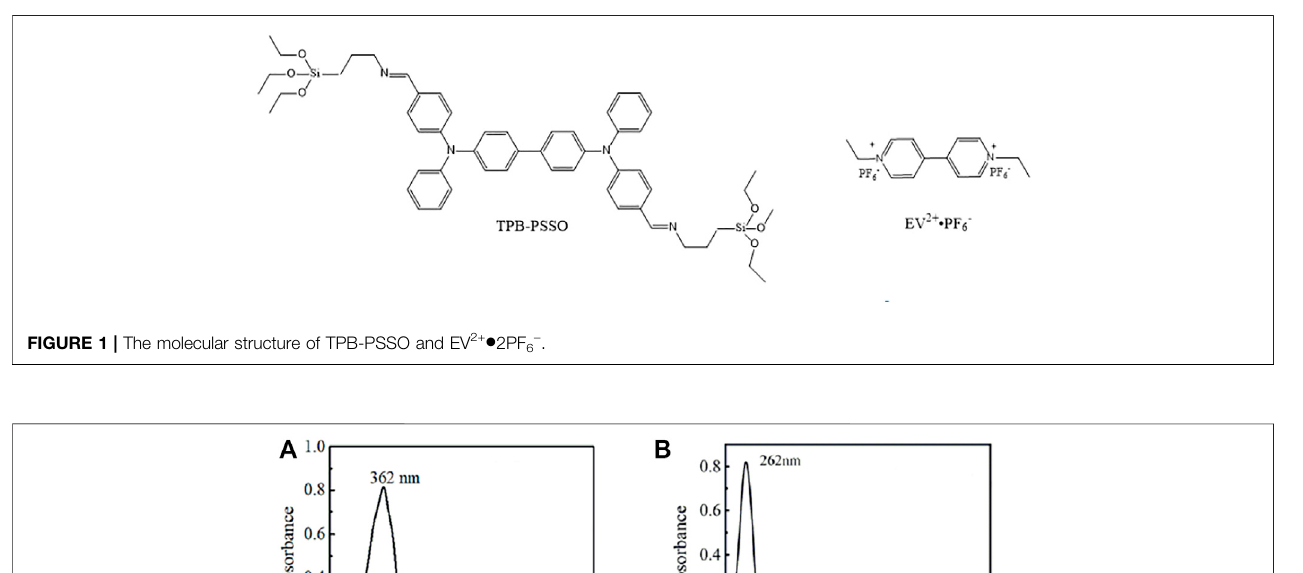
FIGURE 2 | The UV-vis spectra of TPB-PSSO (A) and EV 2+